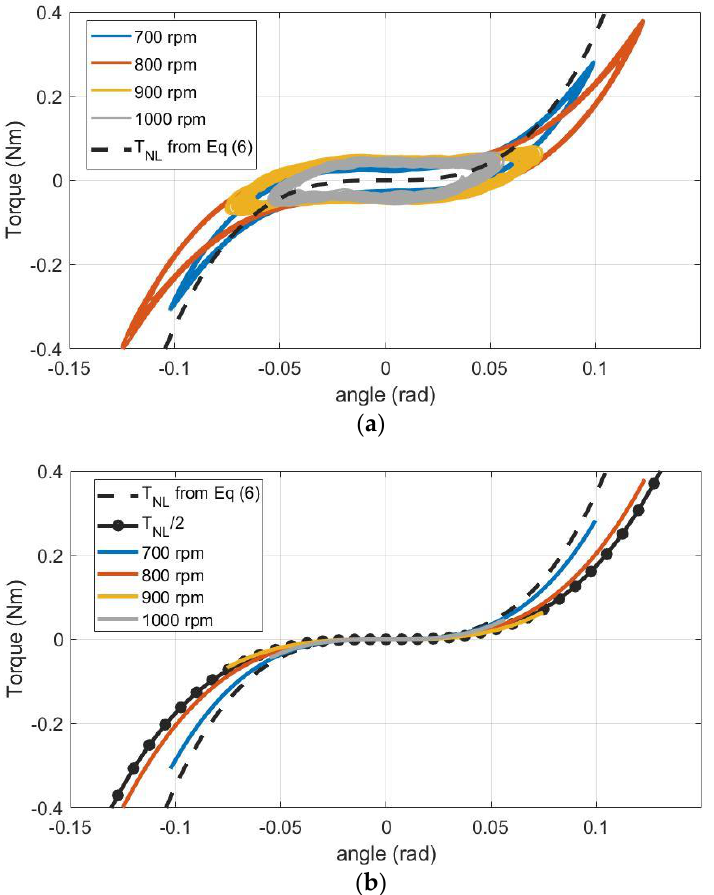
Figure 10. ( a ) Identification of the NES restoring torque computed from the experimental results for pinion speeds of 700, 800, 900 and 1000 rpm and comparison against the model results T NL given by Equation (6); ( b ) elimination of damping from the restoring torque and comparison with NES model torque with two working shims (T NL ) and only one working shim (T NL